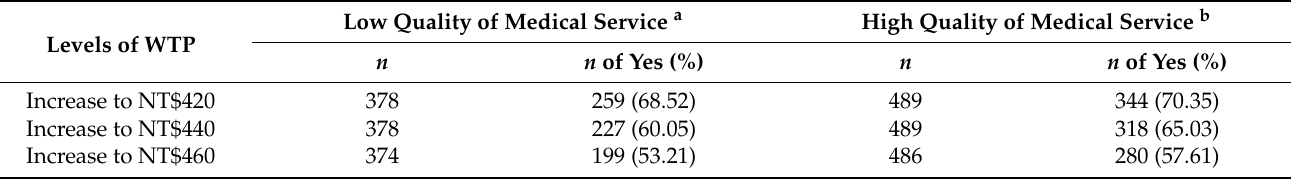
Table 6. Numbers and proportions of respondents in the different levels of WTP for the two groups of medical service